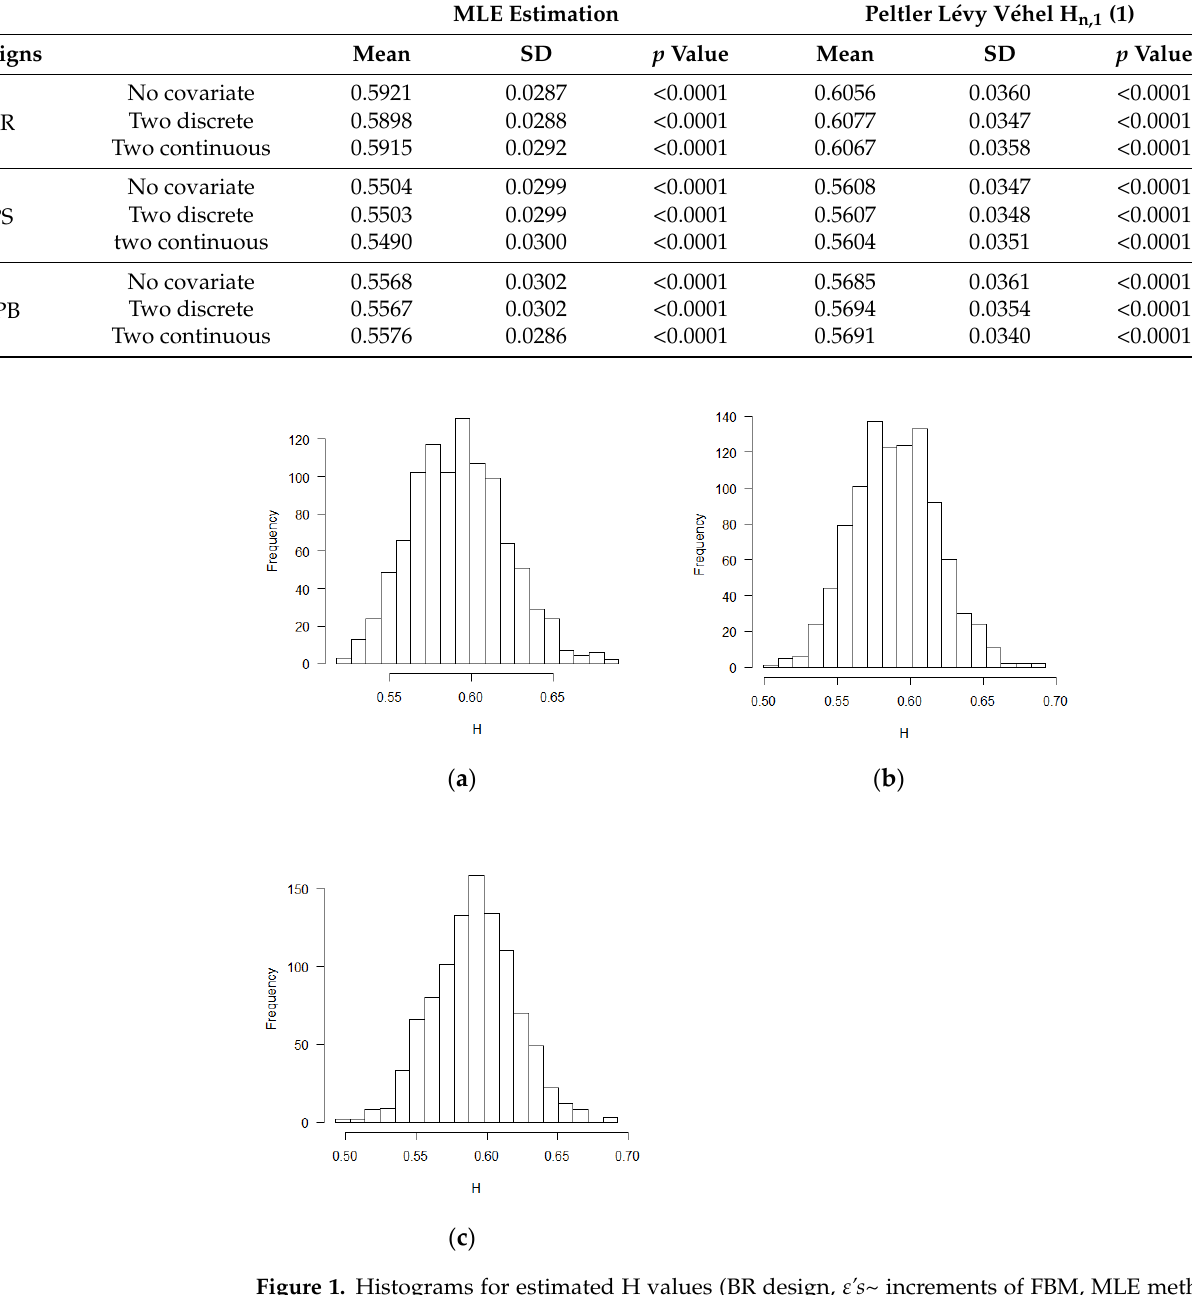
Table 1. Hurst exponent estimations for covariate adaptive randomized clinical trials, ε ’s ~increments of FBM, 𝜇 (cid:2869) , 𝜇 (cid:2870) , 𝛽 (cid:2869) , 𝛽 (cid:2870) , 𝑝 (cid:2869) ,𝑝 (cid:2870) (0.5, 0.5, 1, 1, 0.5, 0.5).